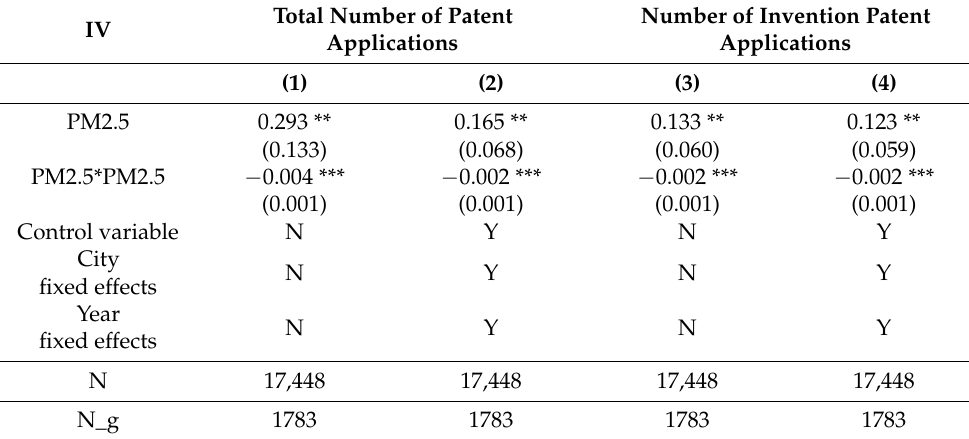
Table 11. Inverted U-shaped relationship of PM2.5 affecting